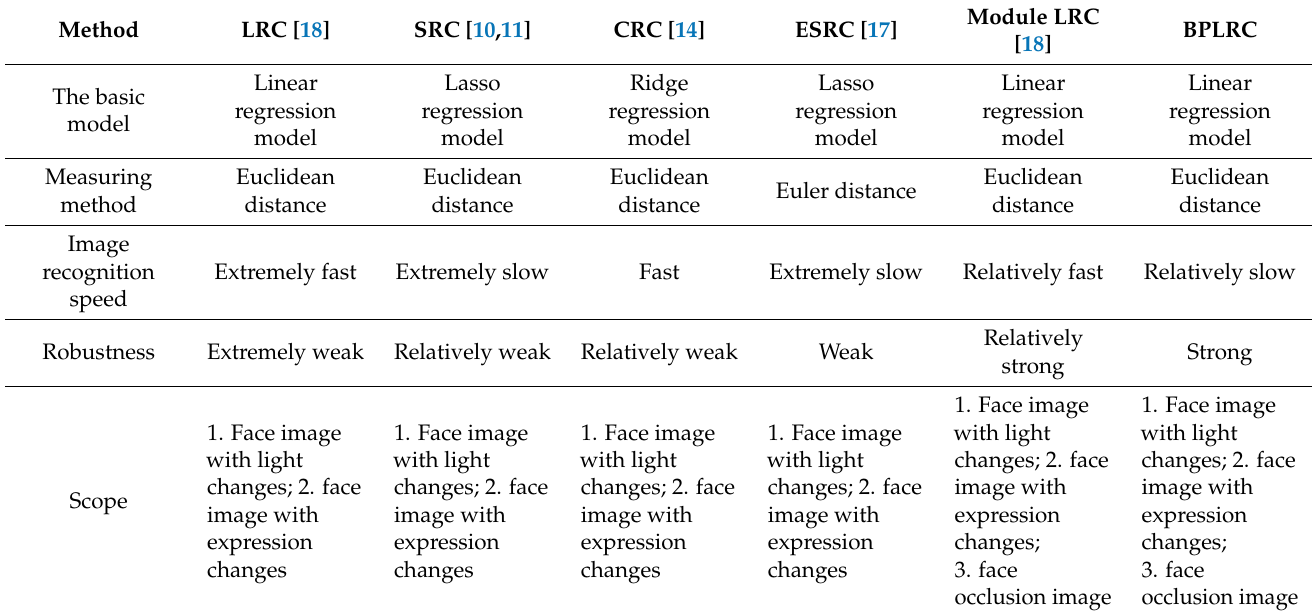
Table 13. Attribute comparison with prior